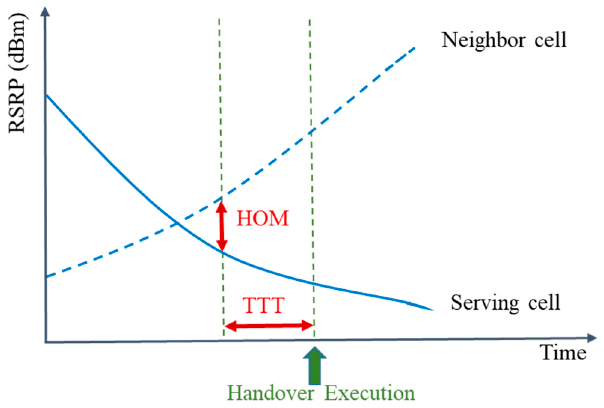
Figure 2. Event A3 handover procedure.